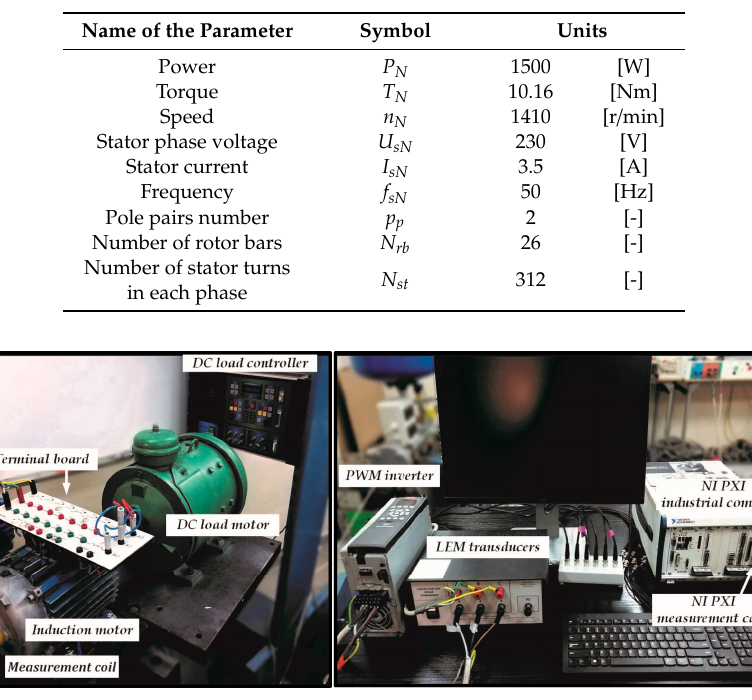
Figure 6. Real view of the experimental set-up.